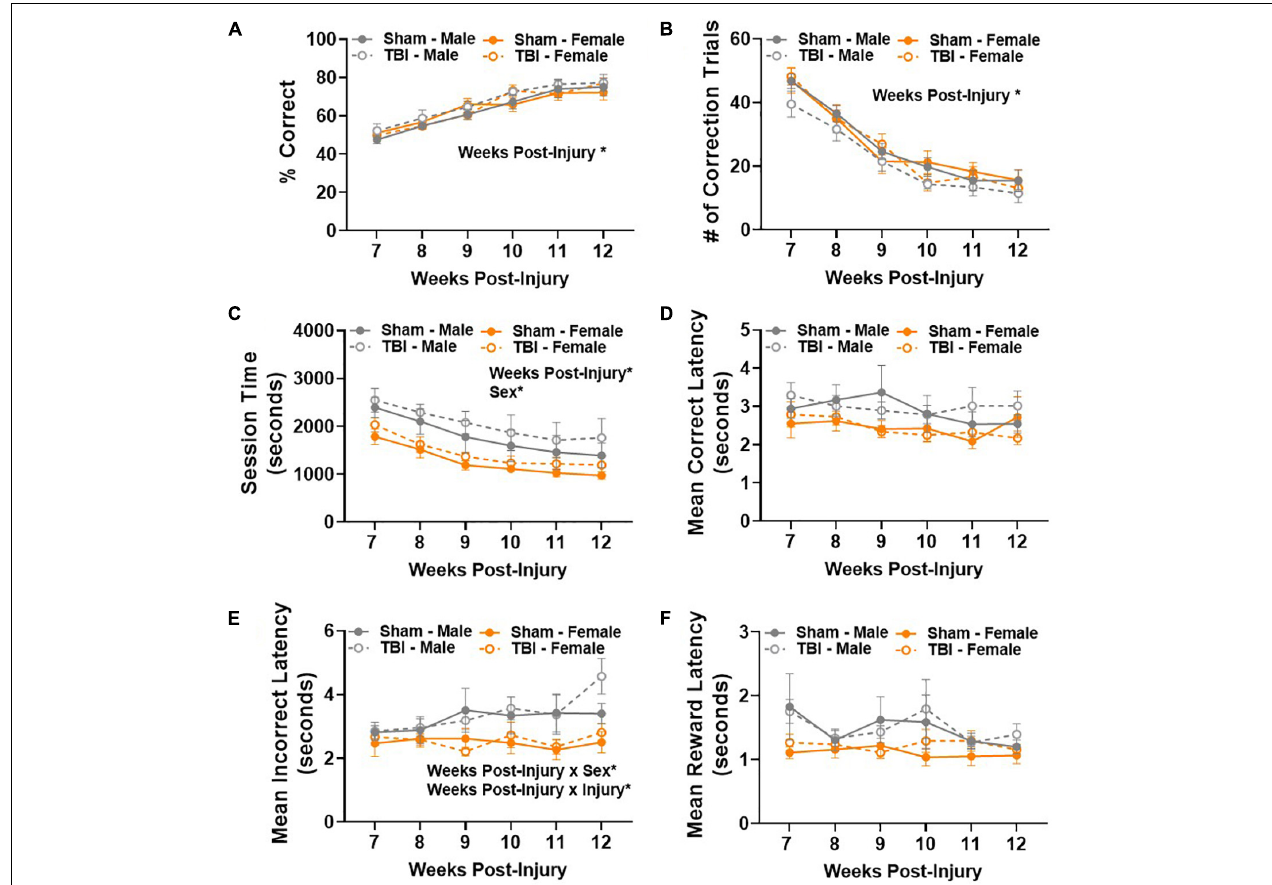
FIGURE 3 | Sex-specific response time does not significantly compromise retrograde memory after TBI. (A) Percent correct increased in all experimental groups 7–12 weeks post-injury. (B) Number of correction trials decreased in all experimental groups 7–12 weeks post-injury. (C) Average session time decreased in all experimental groups 7–12 weeks post-injury, but males took longer than females regardless of injury group. (D) Mean correct latency did not change between experimental groups 7–12 weeks post-injury. (E) Sex- and injury-dependent changes emerged in mean incorrect latency 7–12 weeks post-injury. (F) Mean collection latency did not differ between experimental groups 7–12 weeks post-injury. N = 7–8/group; error bars indicate SEM. Main effects are identified in the figure, unless an interaction effect was identified. * p <